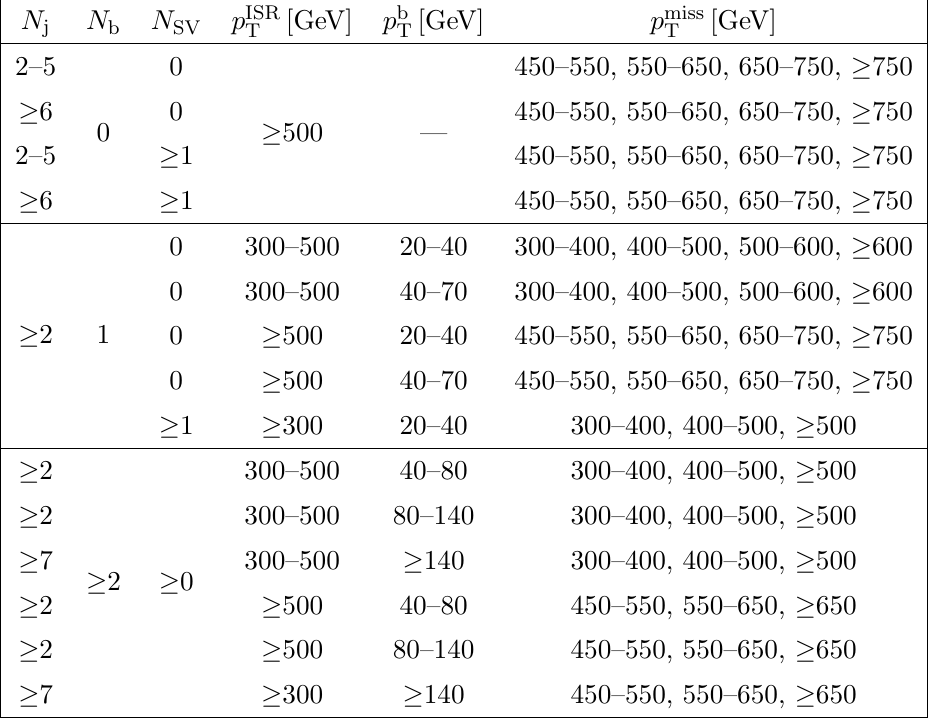
Table 2 . Summary of the 53 non-overlapping search regions that mainly target low (cid:1) m signal. The low (cid:1) m baseline selection is N j (cid:21) 2, p miss m b < 175 GeV (when applicable), j (cid:1) (cid:30) (j 1 ; ~p miss T